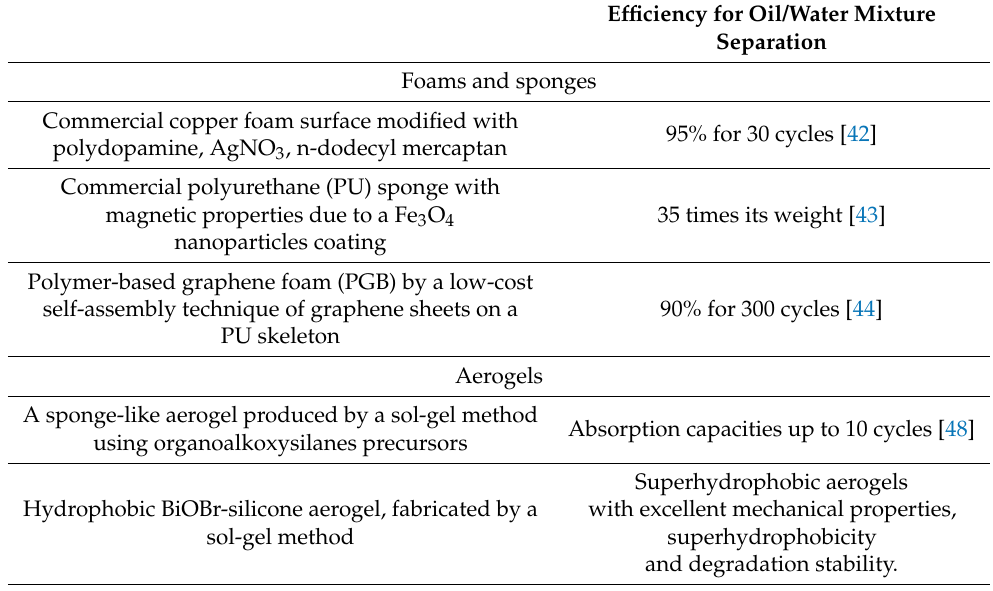
Table 1. Oil removal efficiency for oil/water mixture